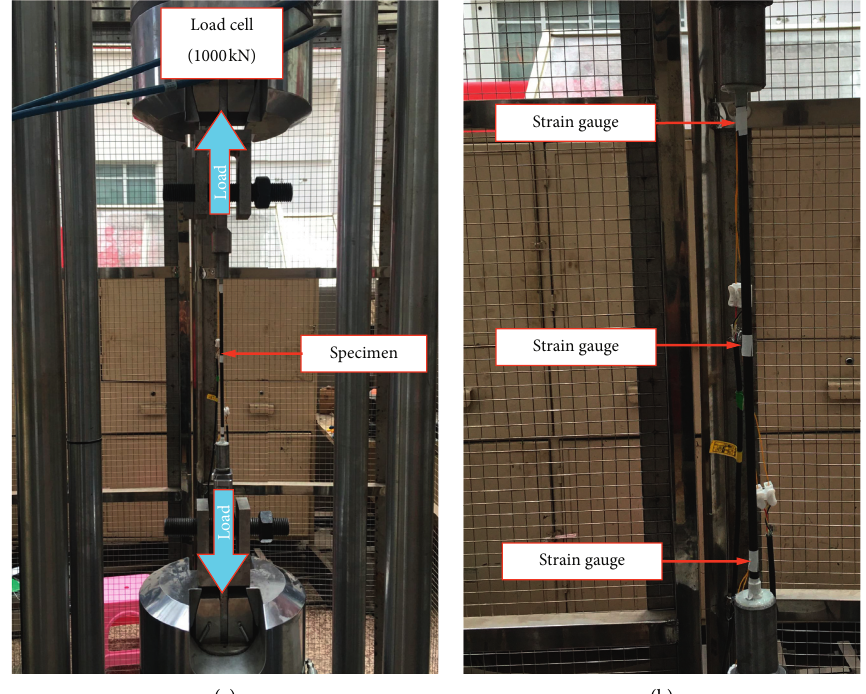
Figure 14: Static tensile test